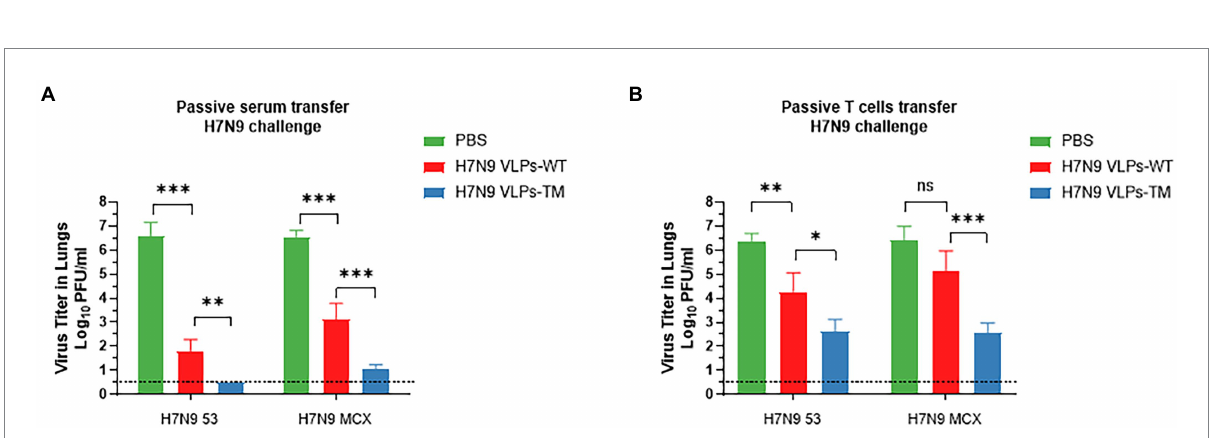
FIGURE 4 Viral load in lung of mice 3 d after challenge, the titer of influenza virus in the lung tissue was assessed by MDCK cell plaque test and expressed as PFU/ml. The data shown represent the mean + standard deviation (error lines) of three mice per group. (A) Passive serum transfer H7N9 challenge. (B) Passive T cell transfer H7N9 challenge. The difference of virus titer between the two groups was analyzed by two-way ANOVA, * p < 0.05, ** p < 0.01, *** p <